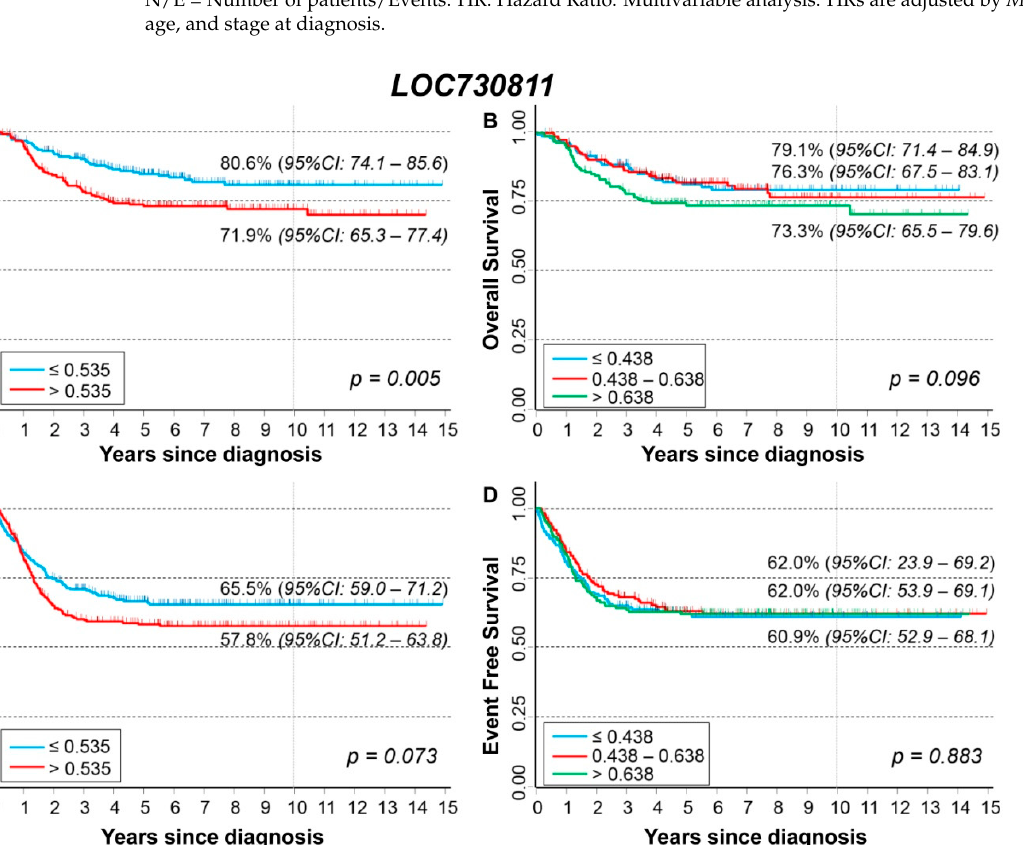
Figure 9. Patient Survival in relation to LOC730811 expression level. Overall Survival of 498 NB patients with ( A ) cut-off based on the median expression value or ( B ) on tertile expression values. Event Free Survival of 498 NB patients with ( C ) cut-off based on the median expression value or ( D ) on tertile expression values. Ten-year survival estimates are displayed. Table 8. Overall Survival of 498 NB patients in relation to LOC730811 expression levels evaluated by the Cox model.